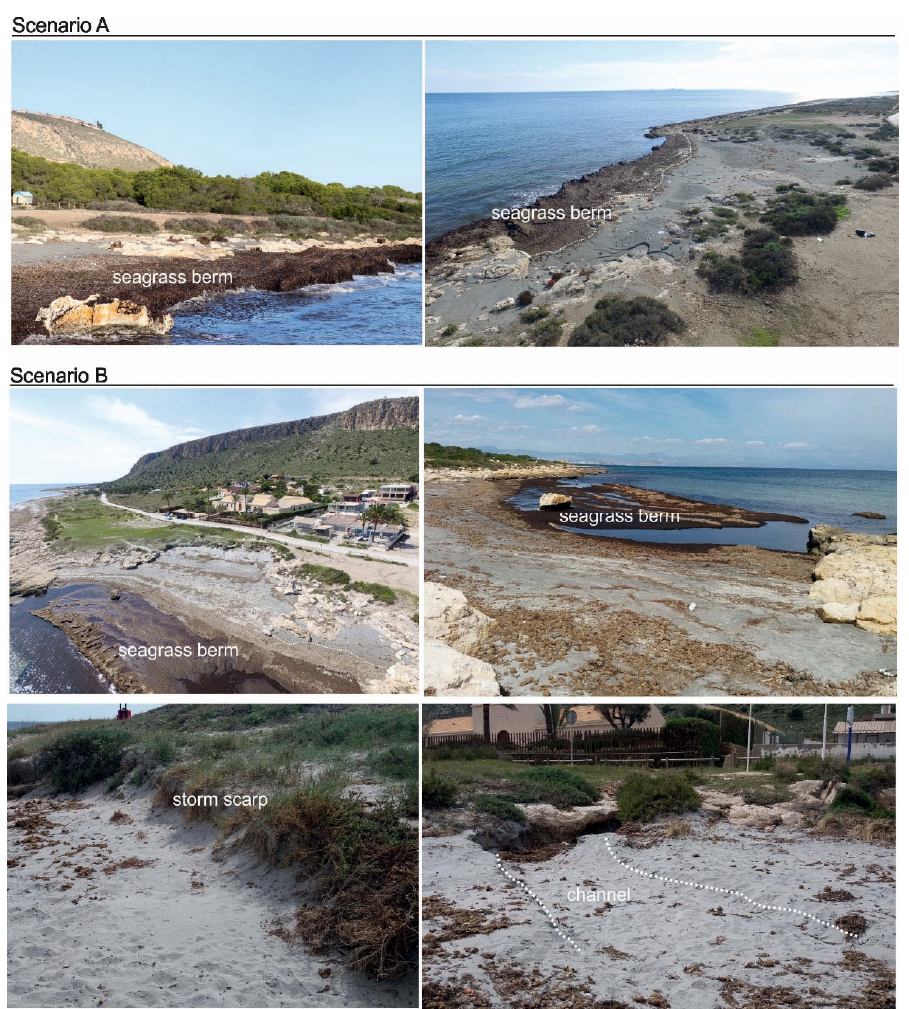
Figure 3. Representative photographs and Remotely Piloted Aircraft Systems images from scenarios A and B (sampling dates: 24 November 2016, and 22 March 2017,